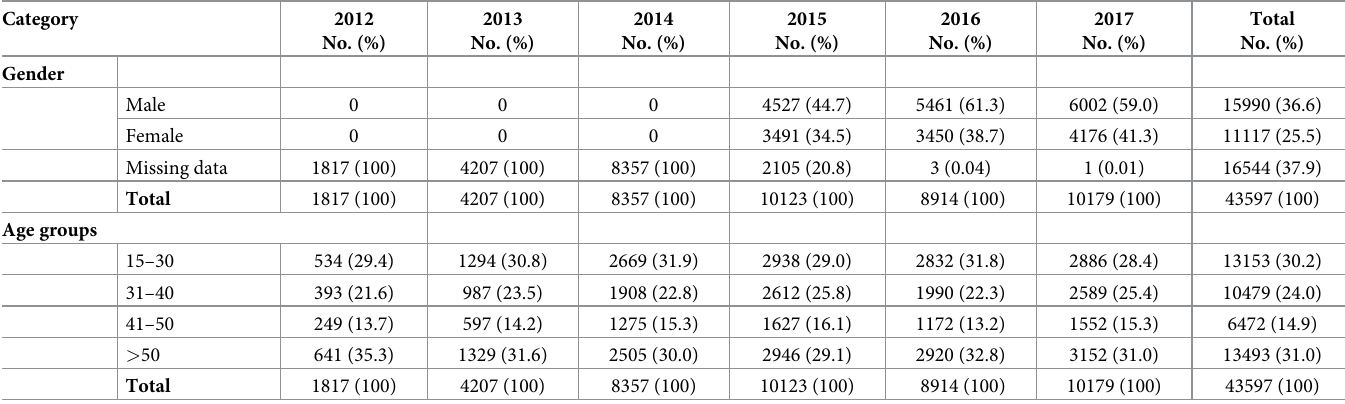
Table 1. Demographic characteristics of the study population.